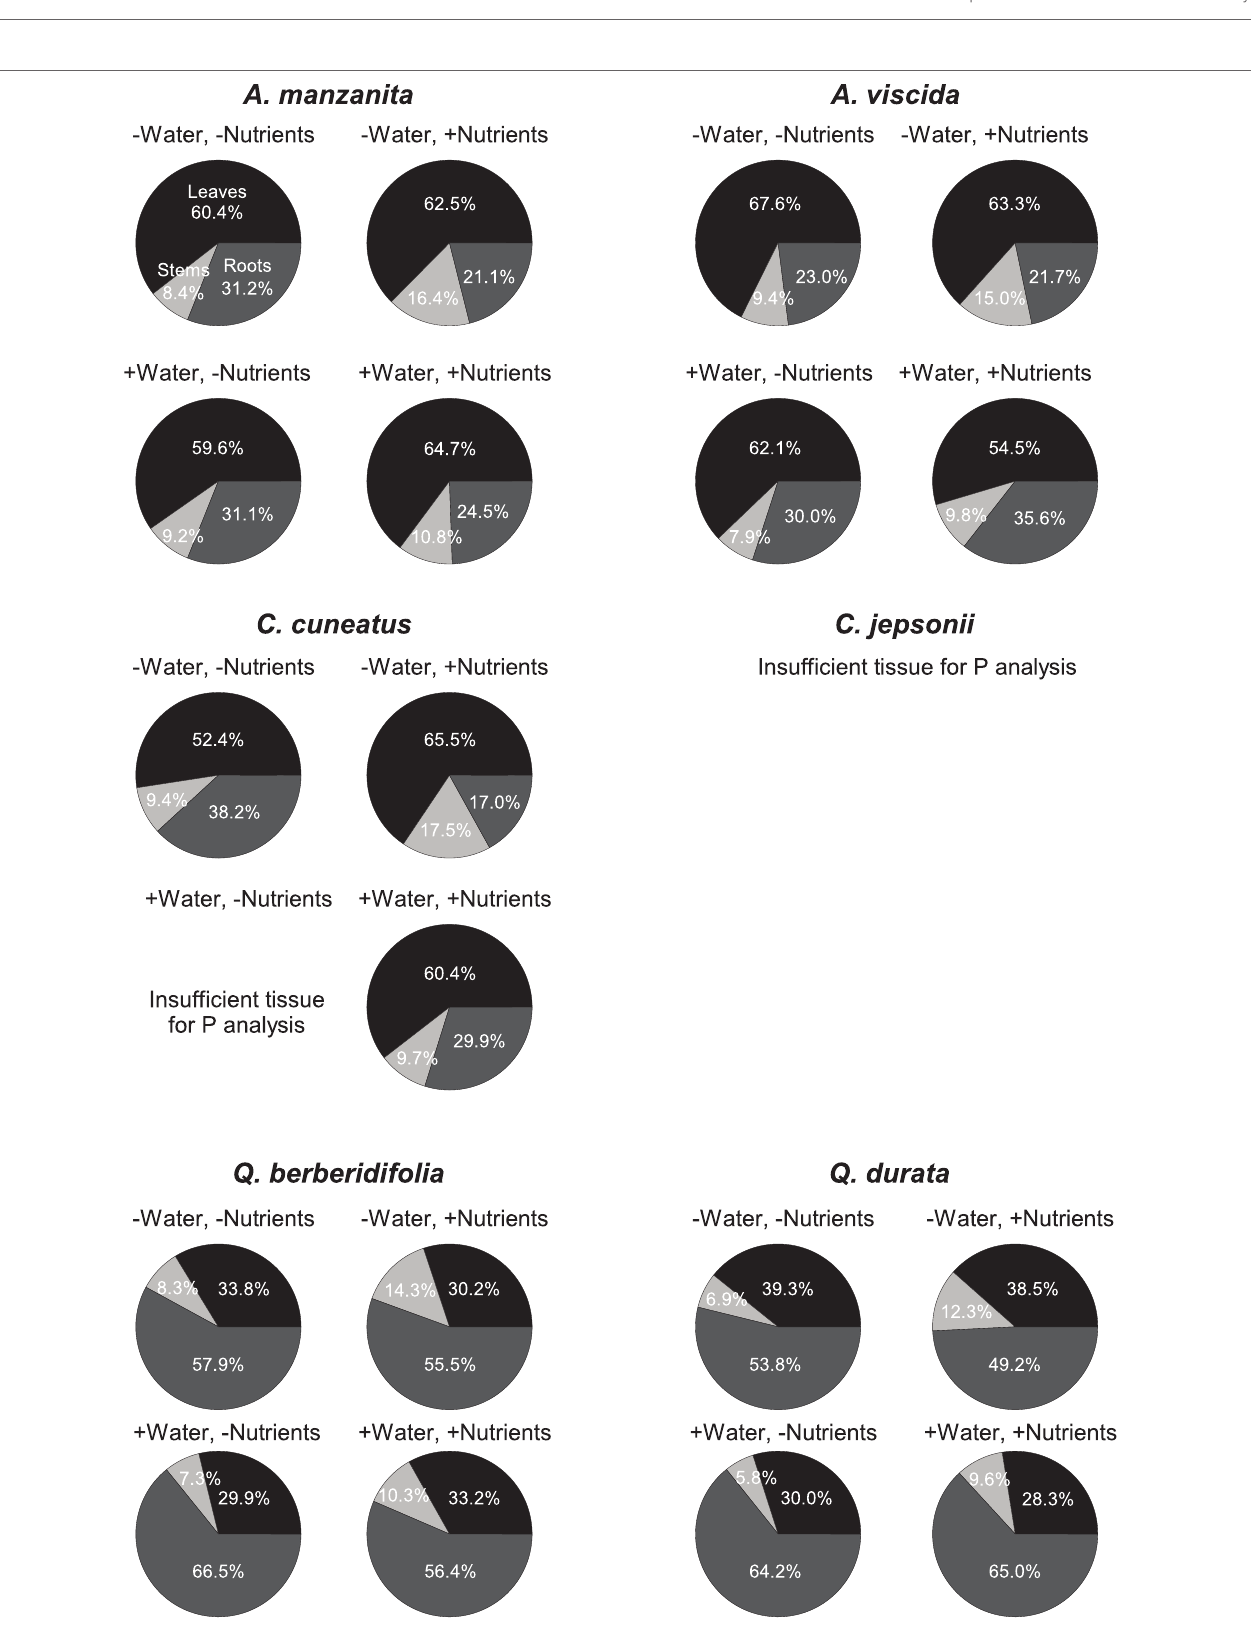
FIGURE 5 | Proportional allocation of P to green leaf (black), stem (light gray), and root (dark gray) P pools. Taxa on left side of figure panel originate from non- serpentine soils, and taxa from the right side of the panel originate from serpentine soils. Data represent mean responses ( n =